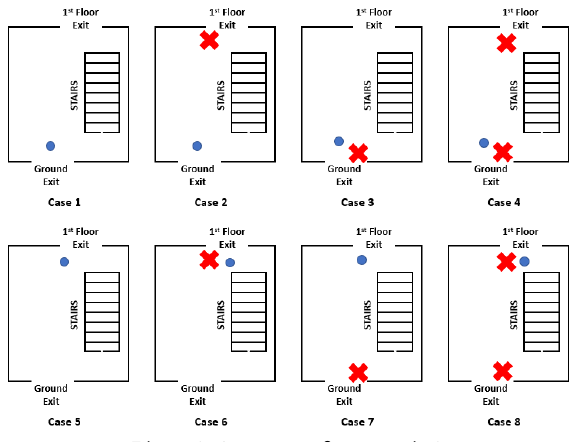
Figure 3. Case setup for scenario 3